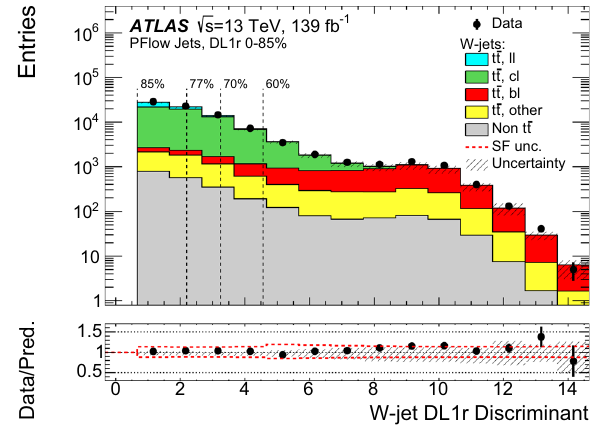
Fig. 5 The DL1r discriminant distribution for tagged particle-flow jets associated with the W boson decay ( W -jets) after applying the b -, c - and light-flavour jet tagging scale factors to the simulation. The red dashed lines (bottom) show the uncertainty from the jet tagging scale factors, while the hashed area shows all other uncertainties excluding the uncertainty on the jet p T distribution, which is derived from the dif- ference between data and simulation. The vertical dashed lines indicate the DL1r discriminant tagging